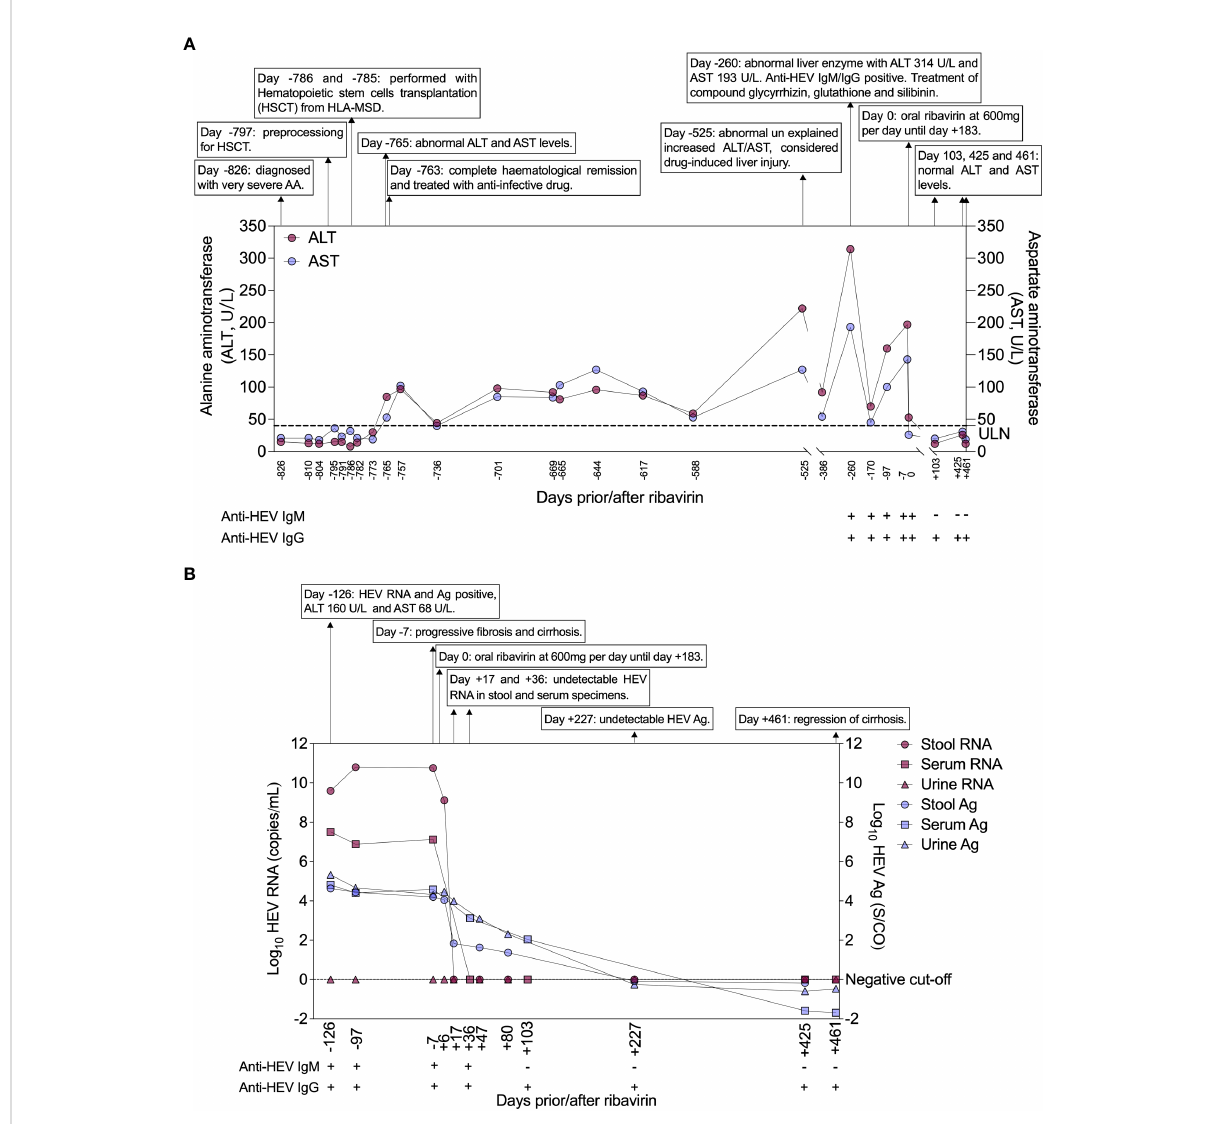
FIGURE 1 Clinical course of HEV infection prior to and after ribavirin. (A) Light red legend indicating ALT (circles) and light blue legend indicating AST (circles). The y-axis on the left represents levels of ALT (U/L) and the right represents levels of AST (U/L). (B) The light red legend indicates HEV RNA of stool (circles) and serum (squares). The light blue legend indicates HEV antigen of stool (circles), serum (squares), and urine (triangles). The y-axis on the left represents viral load of HEV (Log 10 copies/mL) and the right represents levels of HEV Ag (Log 10 S/CO). The x-axis of (A) and (B) are scaled to illustrate time intervals in relation to oral ribavirin. The presence and absence of anti-HEV IgM and anti-HEV IgG in serum are indicated by “ + ” and “–” , respectively. AA, aplastic anemia; Ag, antigen; ALT, Abnormal alanine aminotransferase; AST, aspartate aminotransferase; antigen; IgM, immunoglobulin M; IgG, immunoglobulin